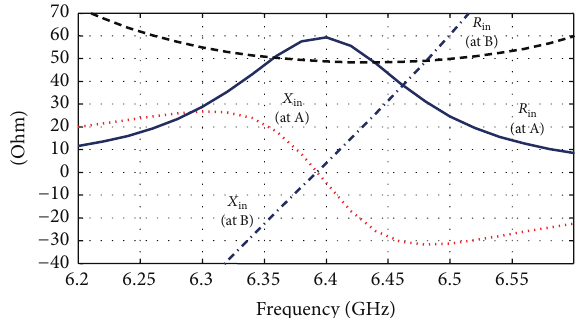
Figure 3: HFSS-simulated input impedance of Figure 1(b) at point A (parallel RLC model) and point B (series RLC